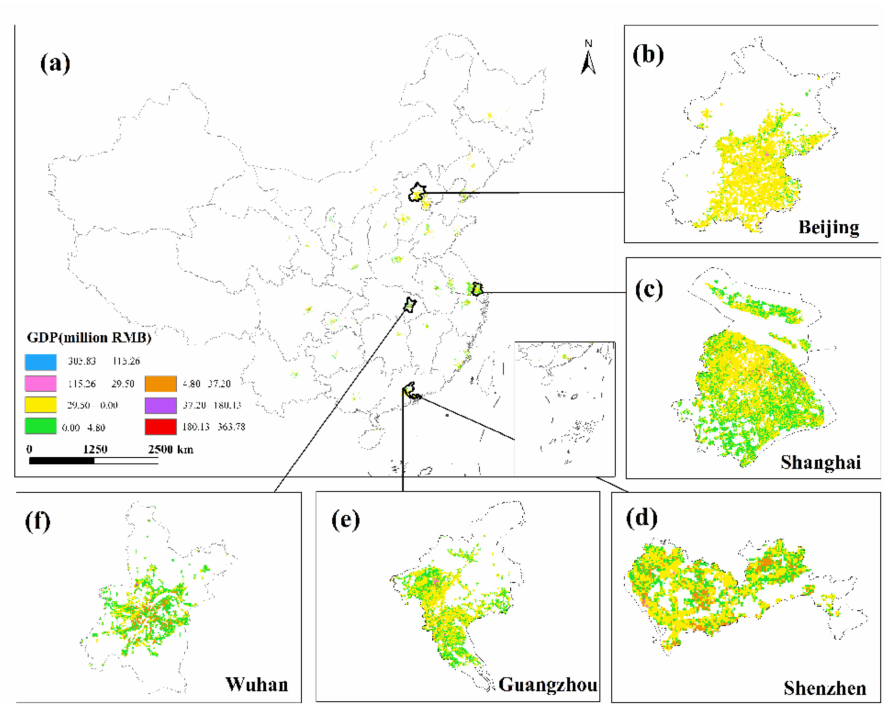
Figure 14. The spatialized result of the sum of GDP in February minus the sum of GDP in January. ( a ) The changes in GDP of 34 cities in China from January to February; ( b ) Beijing; ( c ) Shanghai; ( d ) Shenzhen; ( e ) Guangzhou; ( f )